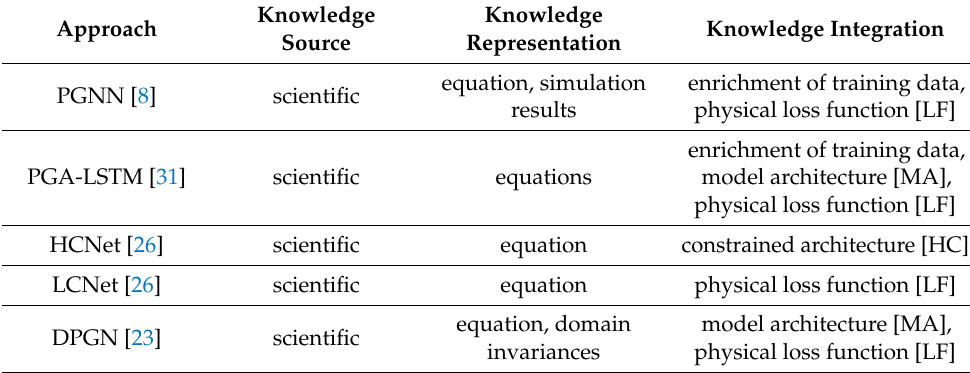
Table 2. Summary of the analyzed state-of-the-art